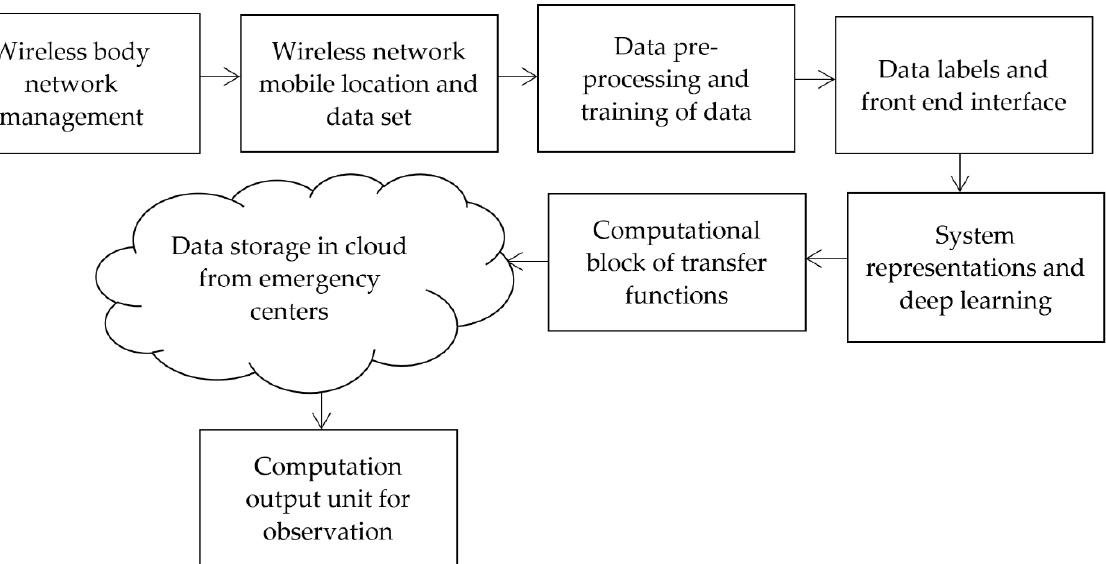
Figure 1. The architecture of the proposed wearable IoT device.